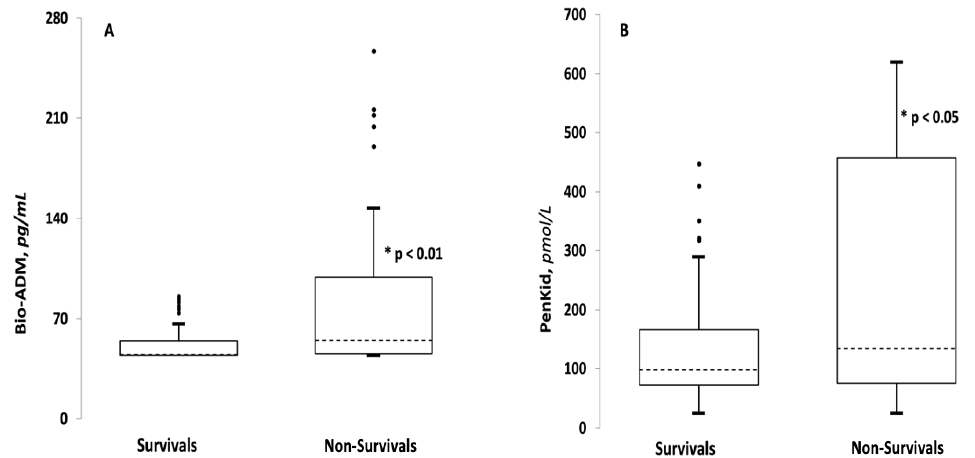
Figure 1. Bio-ADM ( A ) and PenKid ( B ) values in survivals and non-survivals. Median (dash line) and IQR (box) ± 95%CI. Extreme values in bold circles (The dots above the box plots represent outliers values; The * identifies the p value).